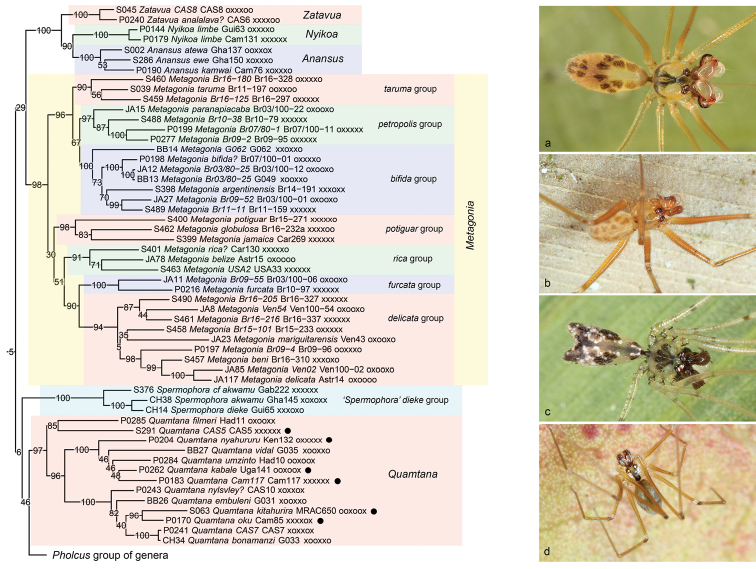
Pholcinae ‘group 2’ (Zatavua and relatives, Metagonia), and Quamtana (marked: non-South African species). Photos aMetagoniataruma (Brazil) bMetagonia sp. n. “Br07-1” (Brazil) cMetagoniabifida? (Brazil) dQuamtana sp. n. (cf. mabusai) (Germany).